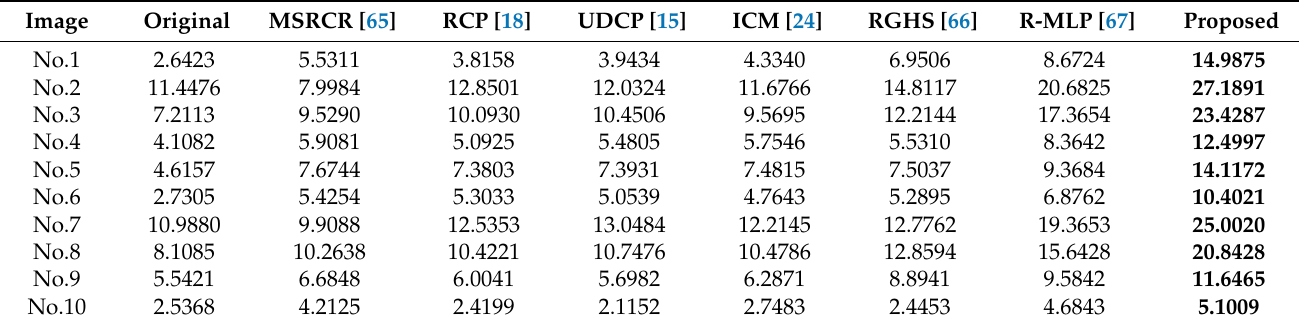
Table 3. Evaluation of images by average gradient.